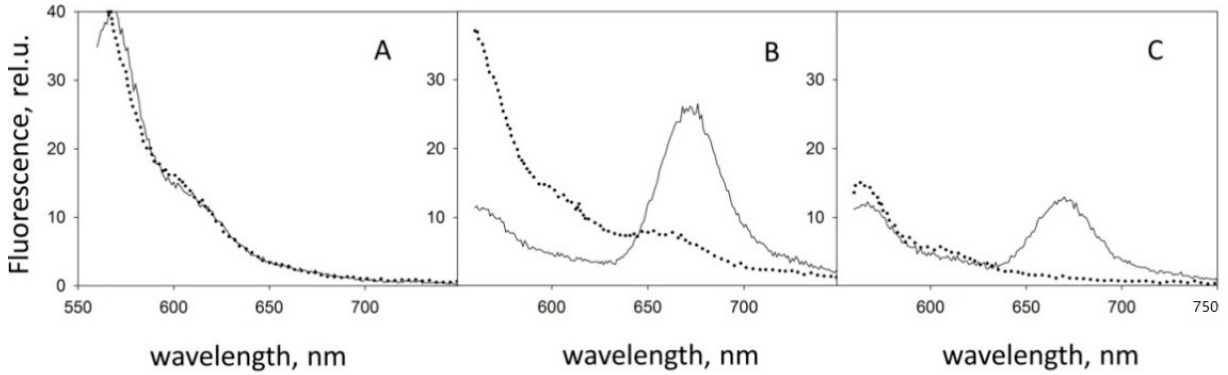
Figure 5. The results of FRET experiments on pure glass (solid lines) and glass surfaces treated by BSA (dotted lines). ( A ) A peptide labeled with Cy3 only; ( B ) a peptide labeled with Cy5 is added; ( C ) fluorescence of the glass surface gently washed with a buffer after measuring the mixture.